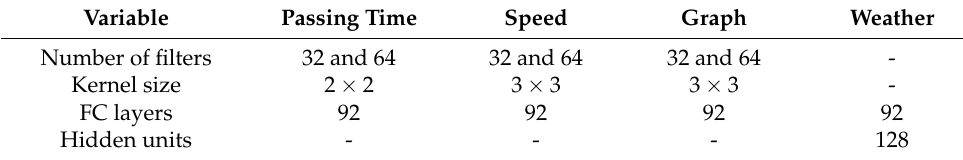
Table 3. Hyper-parameter setting. Variable Passing Time Speed Graph Weather Number of filters 32 and 64 Kernel size FC layers Hidden